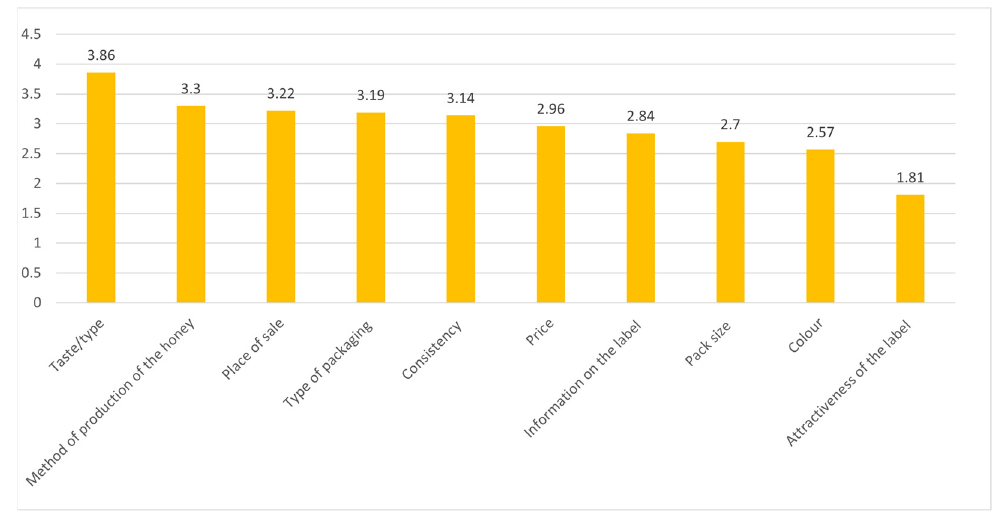
Figure 4. Factors determining the choice of honey ( n = 434, average on a scale: (1—unimportant, 2—rather not important, 3—moderately important, 4—rather important, 5—very important). Table 3. Determinants of purchasing decisions regarding choice of honey ( n = 434, Mann– Whitney